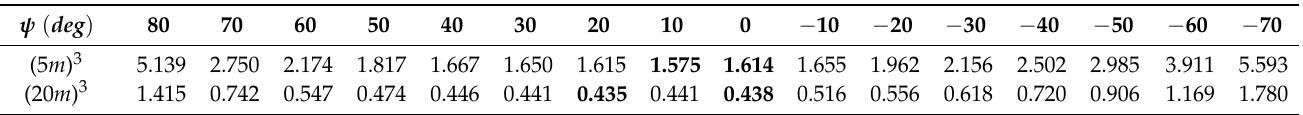
Table 8. The 3D RMSPE ∆ p (m) with varying ψ in the 5 m × 5 m × 5 m and 20 m × 20 m × 20 m environments for the NLOS